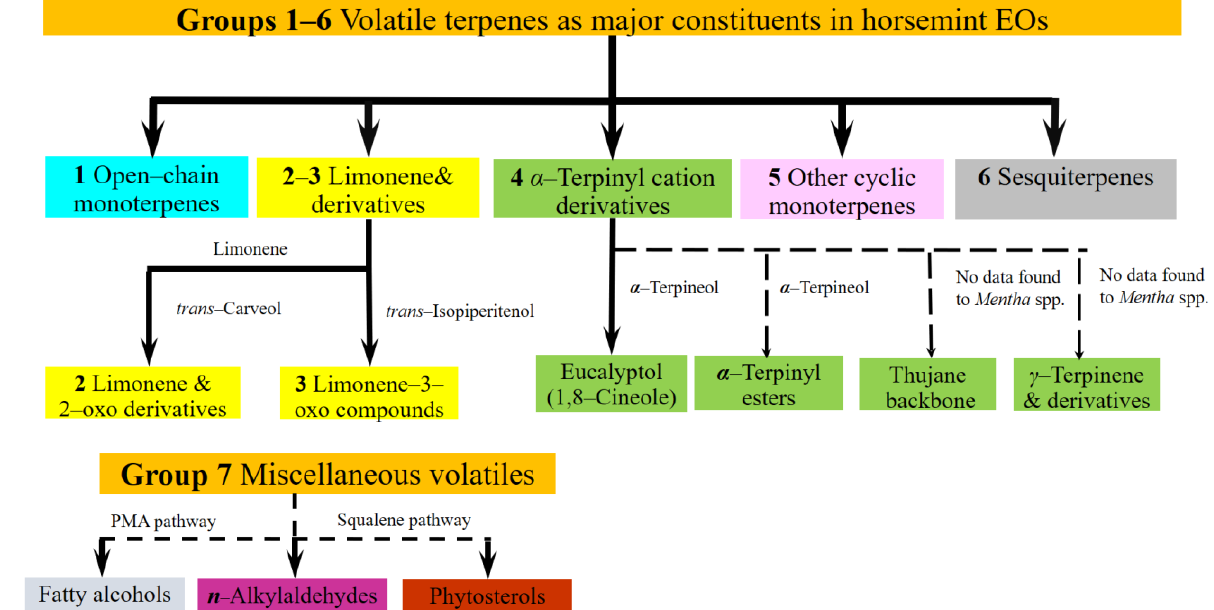
Figure 1. A grouping of M. longifolia essential oil constituents based on structure and biogenetic origin, primarily based on Ba ş er et al., 1999 [4], and Llorens-Molina, 2015 [11]. Solid lines indicate frequent components or groups, broken ones symbolize those which are rather rare or detected only once. Individual compound names next to the arrows are important intermediates of the pathway between the initial and the final compound group, based on [11]. ‘No data found for Mentha spp.’: the description of the branches of the metabolic pathway of α -terpinyl cation to thujane-backbone monoterpenes and to γ -terpinene derivatives was not found in the literature on Mentha spp., although the steps of these pathways are known from other Lamiaceae plants [12,13].